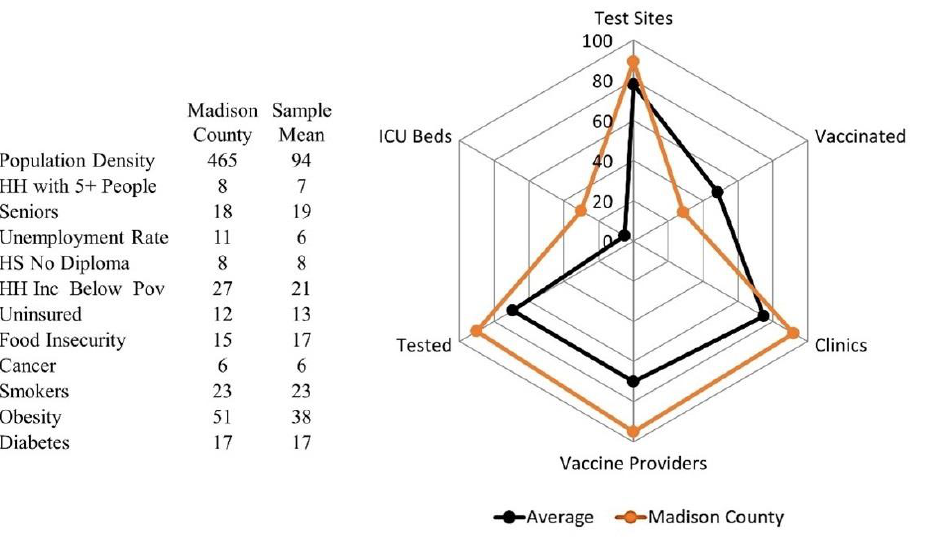
Figure 14. County profile for Madison County compared with the average for all the state’s counties (values are percentages).